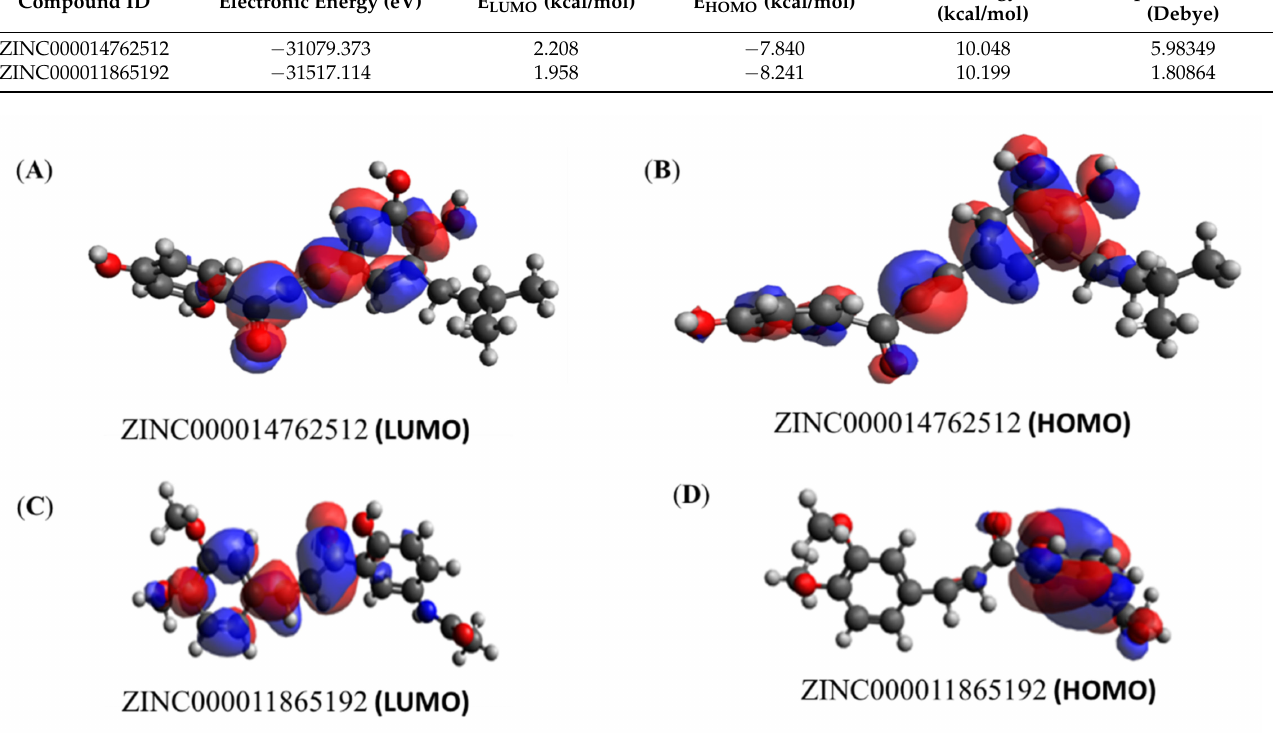
Figure 6. LUMO and HOMO plots of ZINC000014762512 and ZINC000011865192. The color ‘red’ represents positive electron density, while the color ‘blue’ represents negative electron